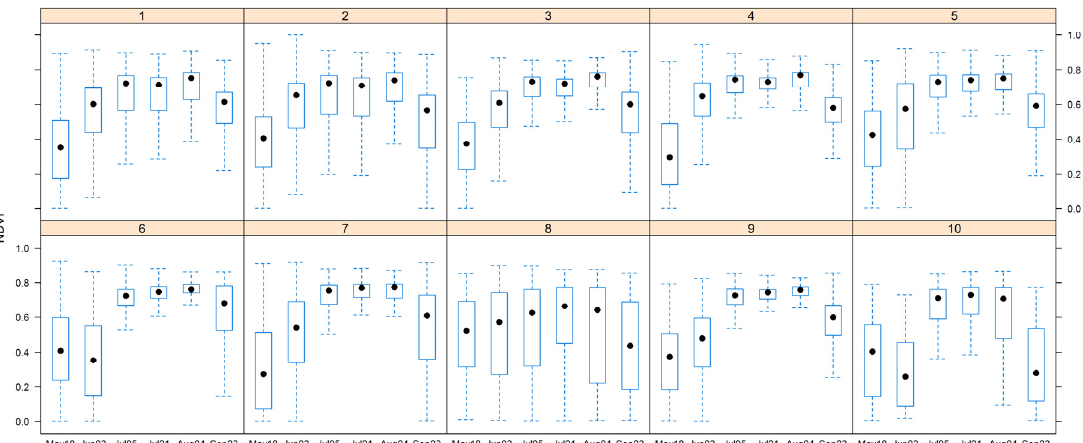
Figure 4. Positive NDVI values for the 10 basins of Lake Tisza in 2015.